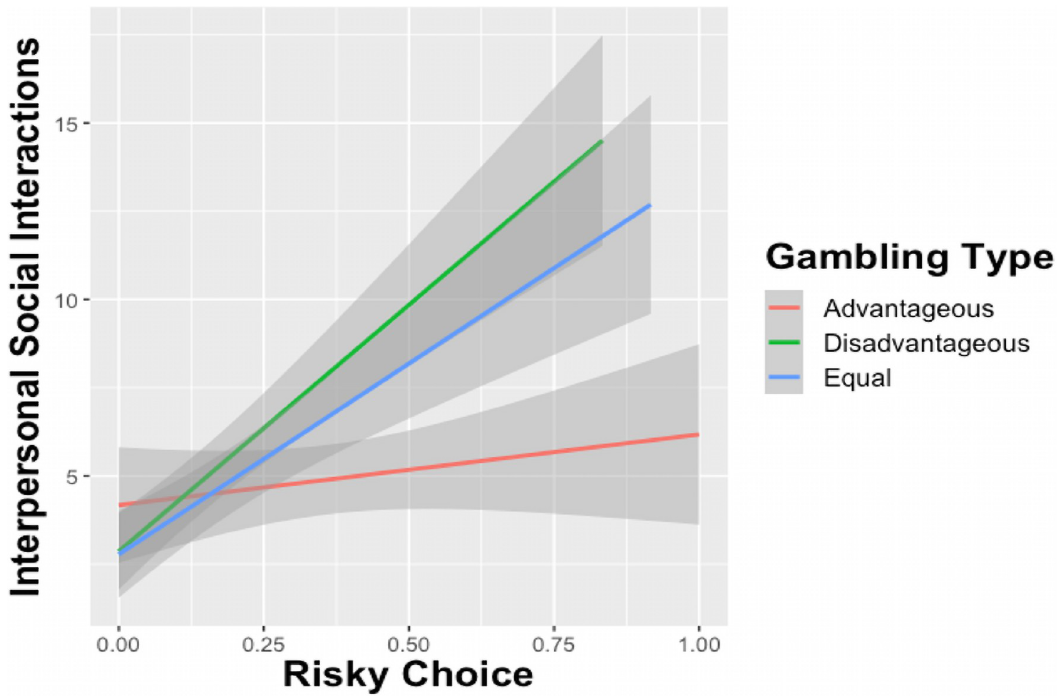
Fig 2. Effect of risky choice on number of interpersonal social interactions by gambling type. Advantageous gambles indicate that the expected value for the risky choice was higher than the safe gamble. Disadvantageous gambles indicate that the expected value for the risky option was lower than the safe option, and the expected values for both safe and risky choices were the same for Equal gambles. The results demonstrated that choosing a higher proportion of Disadvantageous and Equal Gambles predicted a greater number of interpersonal social interactions, meaning that participants engaged in less rigorous social